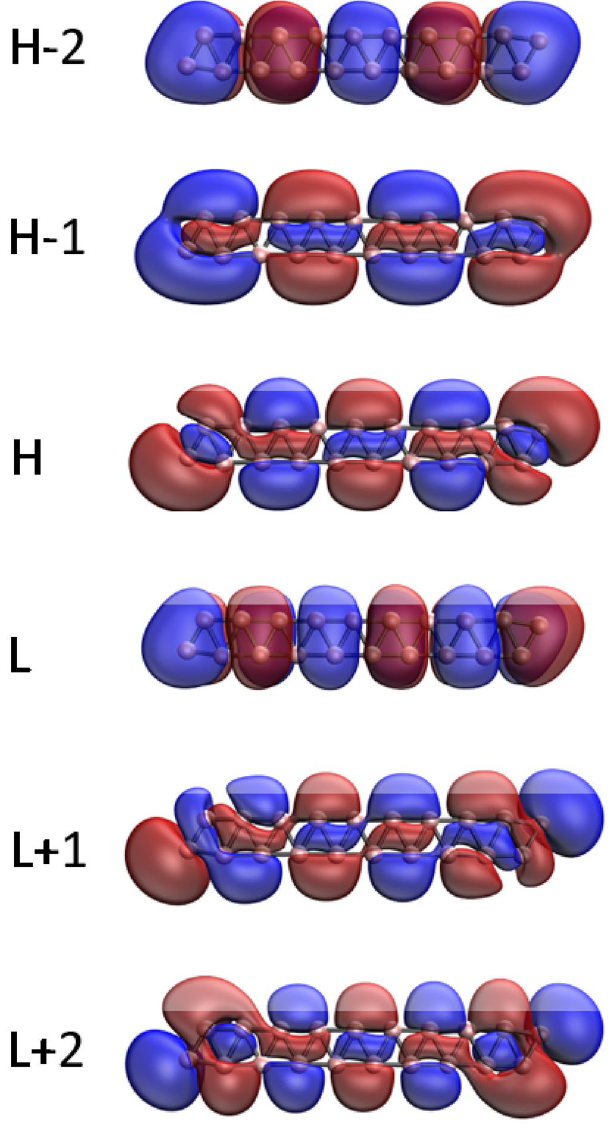
Figure 7. Visualization of the HOMO − 2 (1.995), HOMO − 1 (1.982), HOMO (1.273), LUMO (0.655), LUMO + 1 (0.091), and LUMO + 2 (0.003) for the ground state of l -BNR[2,10], obtained from spin-restricted TAO- LDA, at isovalue = 0.02 e/Å 3 . The orbital occupation numbers are shown in parentheses. Here, for simplicity, HOMO and LUMO are referred to as H and L,